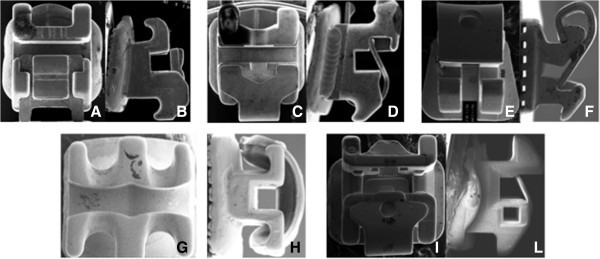
Frontal and lateral views of scanning electron micrograph (SEM) images of tested brackets. Damon SL II (A, B), In-Ovation (C, D), Time 2 (E, F), Synergy (G, H), and Quick (I, L).